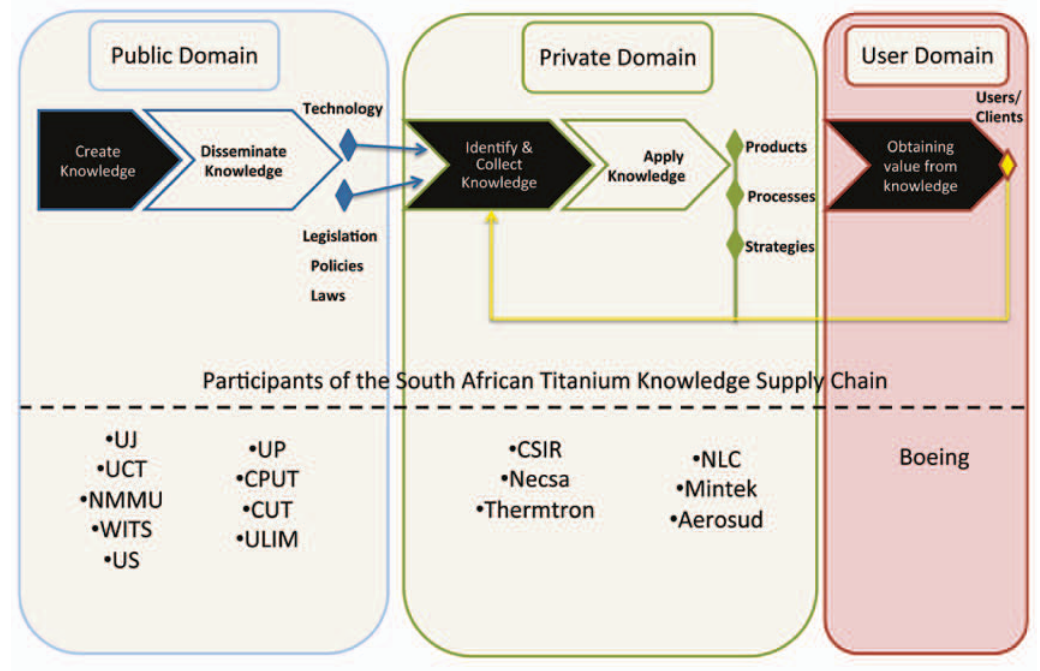
Figure 7: South Africa’s knowledge supply